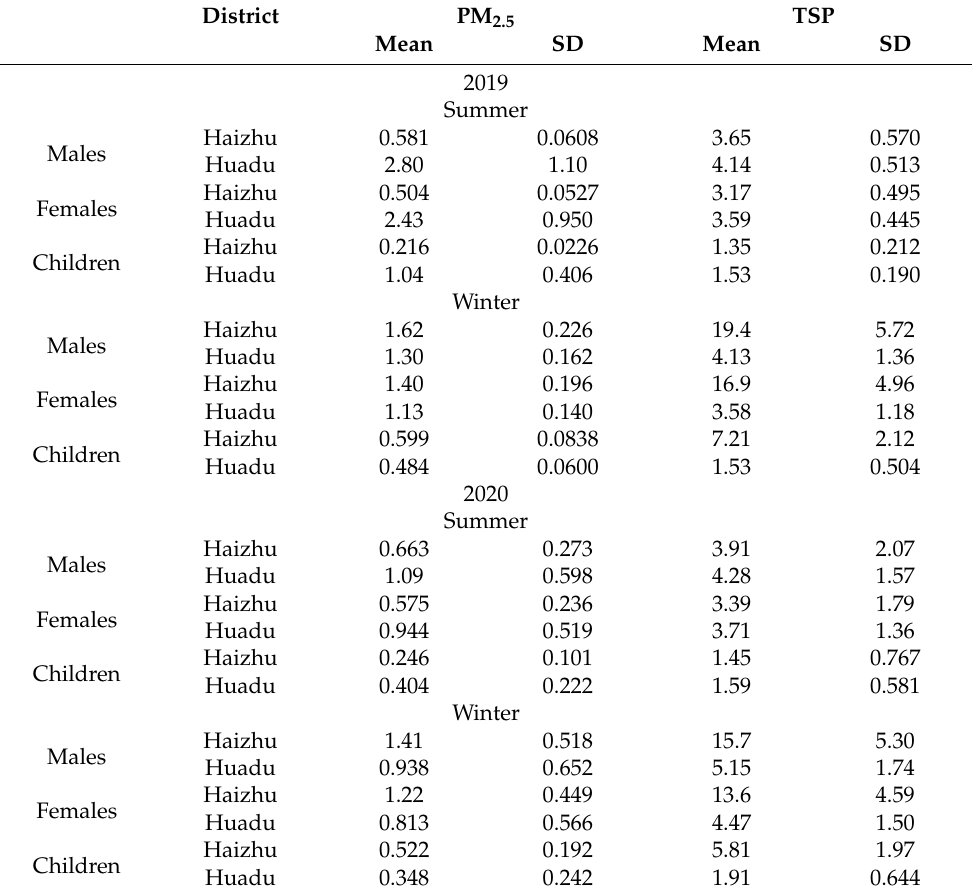
Table 3. Average daily dose (ADD) of three nitro-PAHs (10 − 10 ) in Guangzhou from 2019 to 2020. District PM 2.5